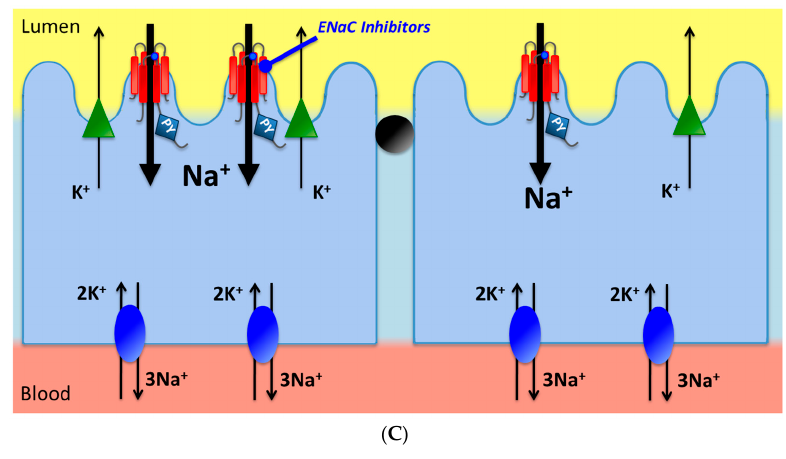
Figure 1. ( A ) Physiopathology of ENaC. Under physiological conditions, the epithelial Na + channel (ENaC) is expressed on the luminal side of distal nephron epithelium. ENaC is positively regulated by aldosterone and antidiuretic hormone and allows the passage of Na + ions from lumen toward cytoplasm. The proline-rich sequence (indicated as PY), located at the C-terminus of each subunit, regulates channel internalization and degradation, through Nedd4 binding and ubiquitination. ENaC function is combined with K + channel ROMK (green triangles) and Na + /K + ATPase (blue ovals) and it is crucial for hydroelectrolytic homeostasis, consisting in sodium renal reabsorption and potassium excretion; ( B ) β and γ subunits mutations. The germline mutations of the SCNN1B and SCNN1G genes causes the loss or disruption of proline-rich sequence that has a pivotal role in negative regulation of the channel. These mutations are gain-of-function and determine an increased membrane density of ENaC and a consequent increase in renal Na + reabsorption; ( C ) α subunit mutation. The germline mutation of the SCNN1A gene affects the extracellular domain, causing the disruption of a disulphide bridge. It is a gain-of-function mutation that leads to an increase of the open probability of the channel and a consequent increase in Na + current, without affecting the PY motif.